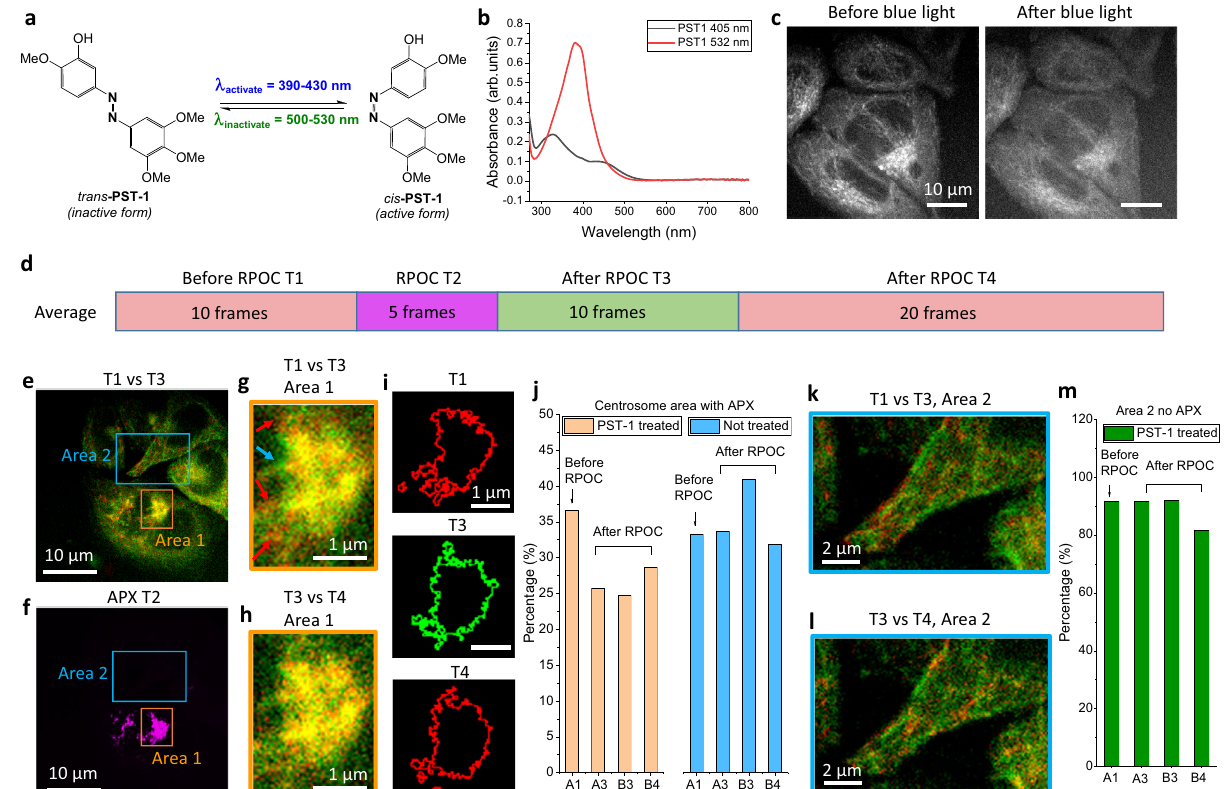
Fig.7|ControlofmicrotubulepolymerizationincellsusingRPOC.a Structures and light responses of PST-1. b UV-Vis spectra of PST-1 after blue and green light exposure. c Averaged two-photon excitation fl uorescence (TPEF) images of EGFP- EB3 signals from transfected Kyoto HeLa cells before and after 400nm light exposure. d Image analysis procedures and four time-windows for EGFP-EB3 TPEF signal comparison. e Overlays of EGFP-EB3 TPEF signals averaged for T1 (red) and T3(green). f Active pixels(APXs) averagedin T2. Cellsare treatedwith 4 μ M PST-1 for 15min before imaging and RPOC. g , h Area 1 selected in panel e (T1 vs T3) and